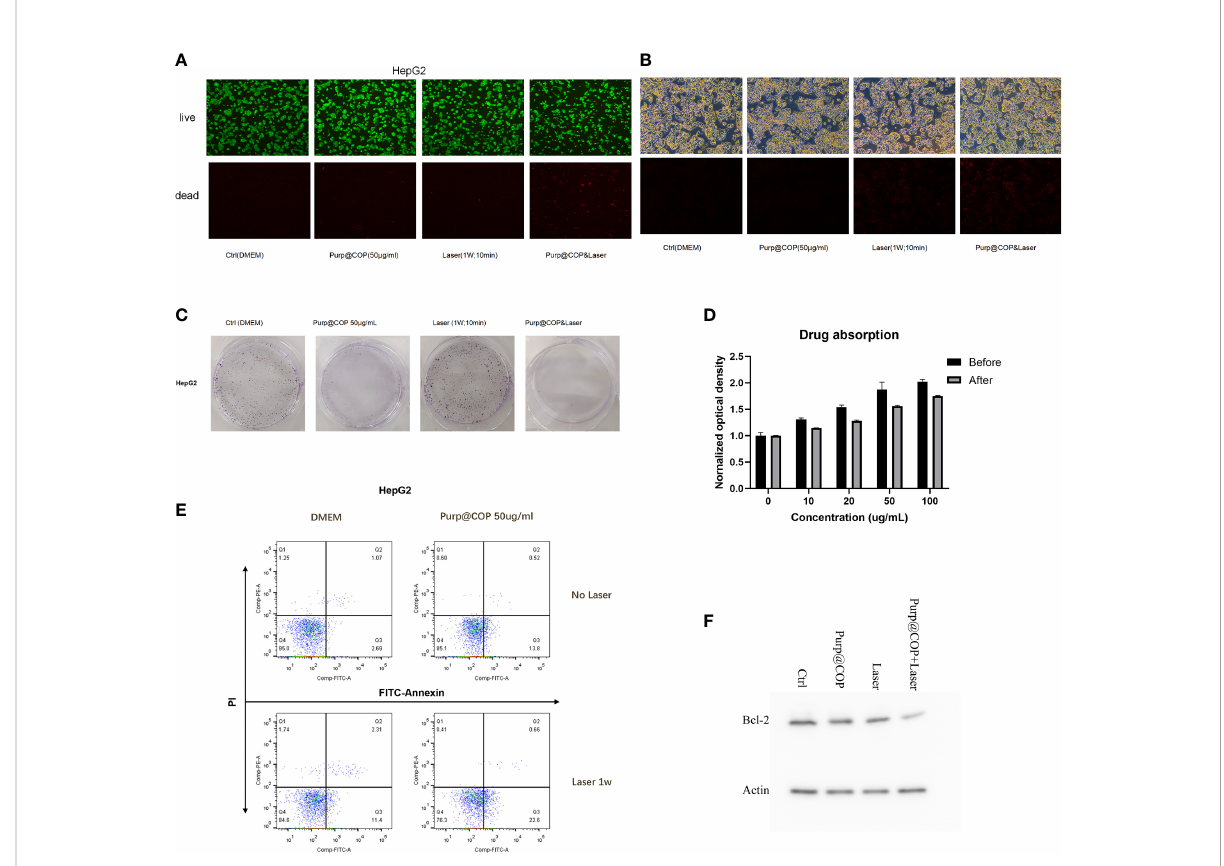
FIGURE 4 Antitumor results of the photodynamic and photothermal effects of Purp@COP. (A) HepG2 cells were treated with or without 50 m g/ml of Purp@COP followed by irradiation with or without 1 W/cm 2 laser for 10 min and then cultured for 24 h before calcein AM and propidium iodide (PI) staining (scale, 20 m m). (B) Results of dihydroethidium (DHE) staining after HepG2 cells were treated with or without 50 m g/ml of Purp@COP followed by irradiation with or without 1 W/cm 2 laser for 10 min (scale, 20 m m). (C) Flow cytometry results of Annexin V and PI staining after HepG2 cells were treated with or without 50 m g/ml of Purp@COP followed by irradiation with or without 1 W/cm 2 laser for 10 min and then cultured for 24 h. (D) Results of crystal violet staining after HepG2 cells were treated with or without 50 m g/ml of Purp@COP followed by irradiation with or without 1 W/cm 2 laser for 10 min and then cultured for 72 h. (E) The drug absorption of HepG2 cells before or after the culture with different doses of Purp@COP. (F) Protein expression of Bcl-2 of HepG2 cells treated with or without 50 g/ml of Purp@COP followed by irradiation with or without 1 W/cm 2 laser for 10 min and then cultured for 24 h. Actin was used as a loading